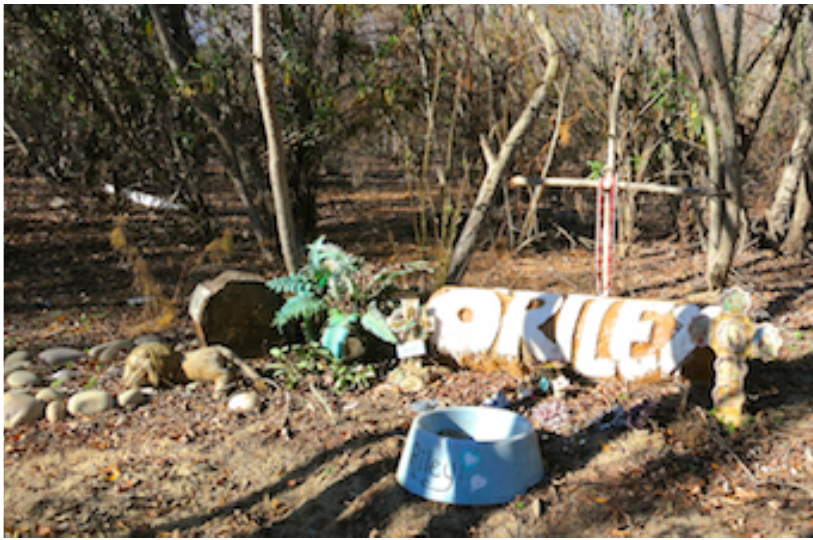
Figure 1. Dog burial site in the river